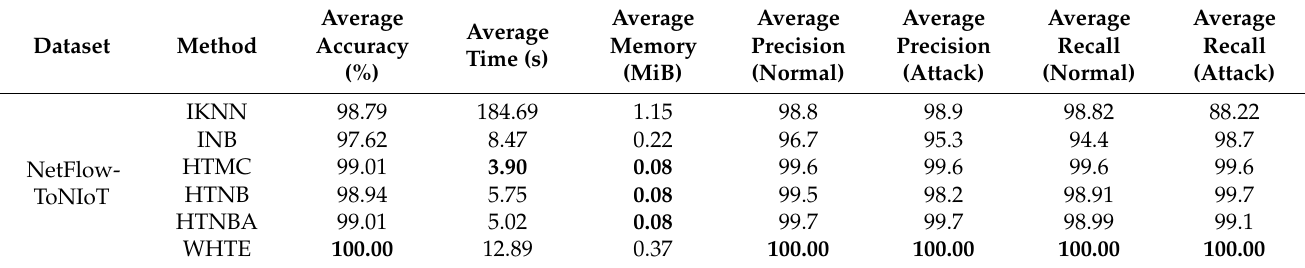
Table 7. The average accuracy, CPU time, and memory usage of the incremental learning methods applied on the NetFlow- ToNIoT